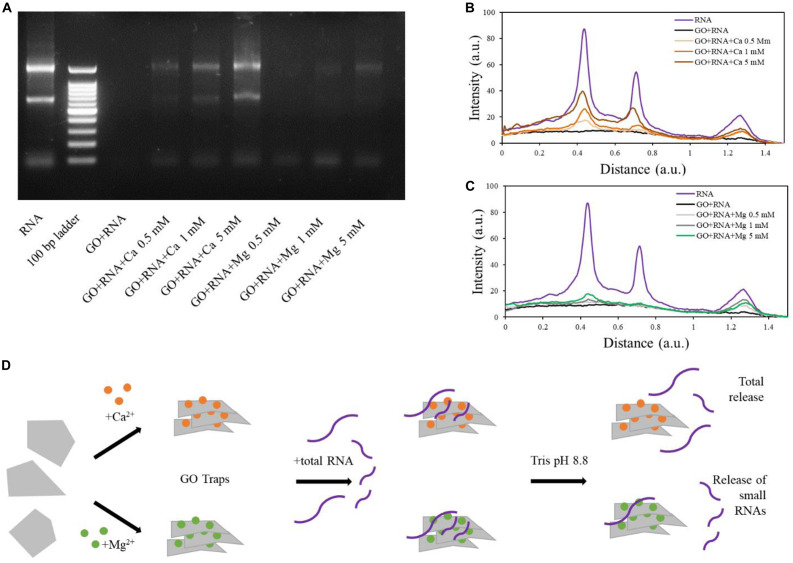
Electrophoretic analysis of supernatants after release from GO sheets in Tris buffer at high pH (A). Line profile analysis of electrophoresis gel and comparison of RNA and GO-RNA samples with GO-calcium (B) and GO-magnesium (C). Schematic illustration of our results (D).